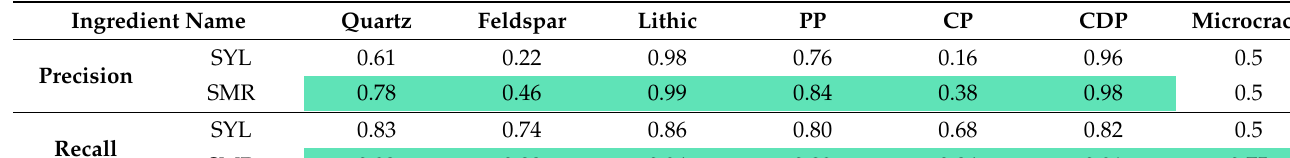
Table 2. Two algorithms for precision and recall statistics of thin sections.